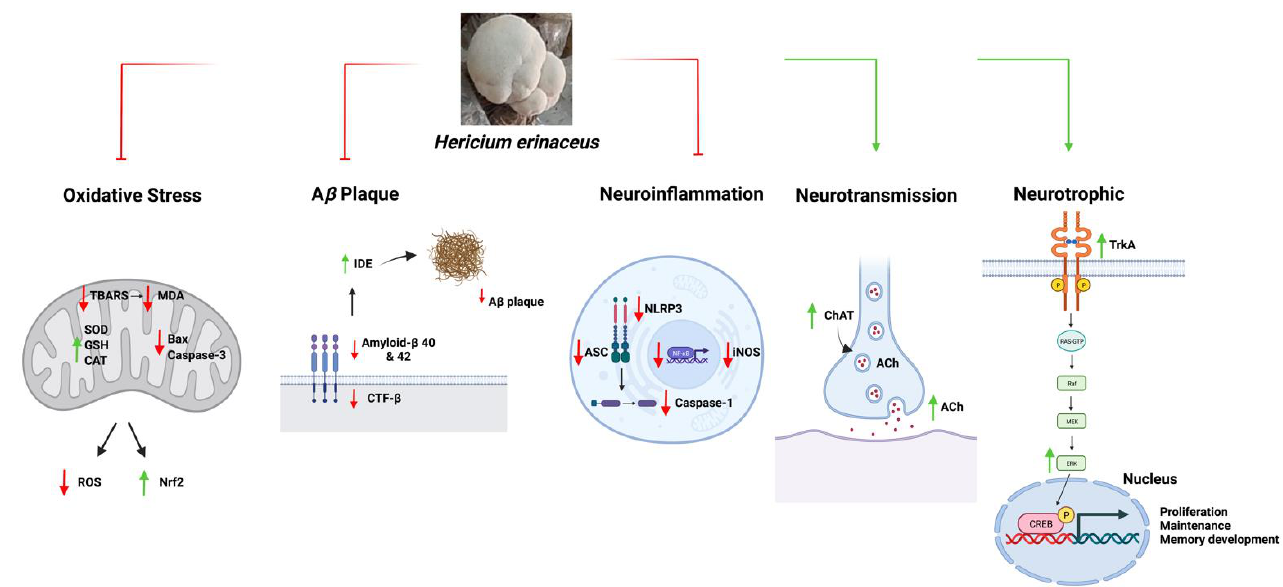
Figure 3. A schematic diagram summarizing the functions of Hericium erinaceus in AD. Abbreviations: ROS, Reactive oxygen species; BAX, Bcl-2- associated X protein; TBARS, Thiobarbituric acid reactive substances; MDA, Malondialdehyde; Nrf2, Nuclear factor-erythroid factor 2-related factor 2; SOD, Superoxide dismutase; CAT, Catalase; GSH, Glutathione; Bcl-2, B-cell lymphoma 2; SDS, Sodium dodecyl sulfate; CTF- β , Beta-carboxyl-terminal fragment; A β , Amyloid-beta; IDE, Insulin-degrading enzyme; iNOS, Nitric oxide synthase; ASC, Apoptosis-associated speck-like protein containing a caspase recruitment domain; NLRP3, NLR family pyrin domain containing 3; NF-kB, Nuclear factor-kappa B; ACh, Acetylcholine; ChAT, Choline acetyltransferase; TrkA, Tropomyosin receptor kinase A; RAS-GTP, Ras protein guanine triphosphatase; Raf, Rapidly accelerated fibrosarcoma; MEK, Mitogen-activated protein kinase; Erk, Extracellular signal-regulated kinase; CREB, cAMP-response element binding protein.